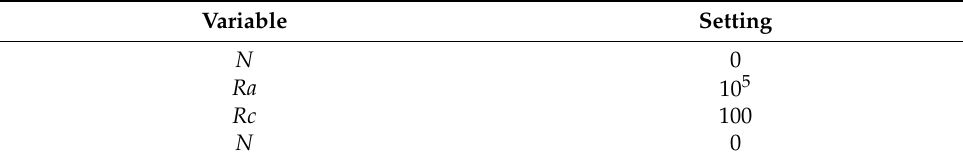
Figure 12. Response optimisation. Table 3. Multiple Response Prediction.